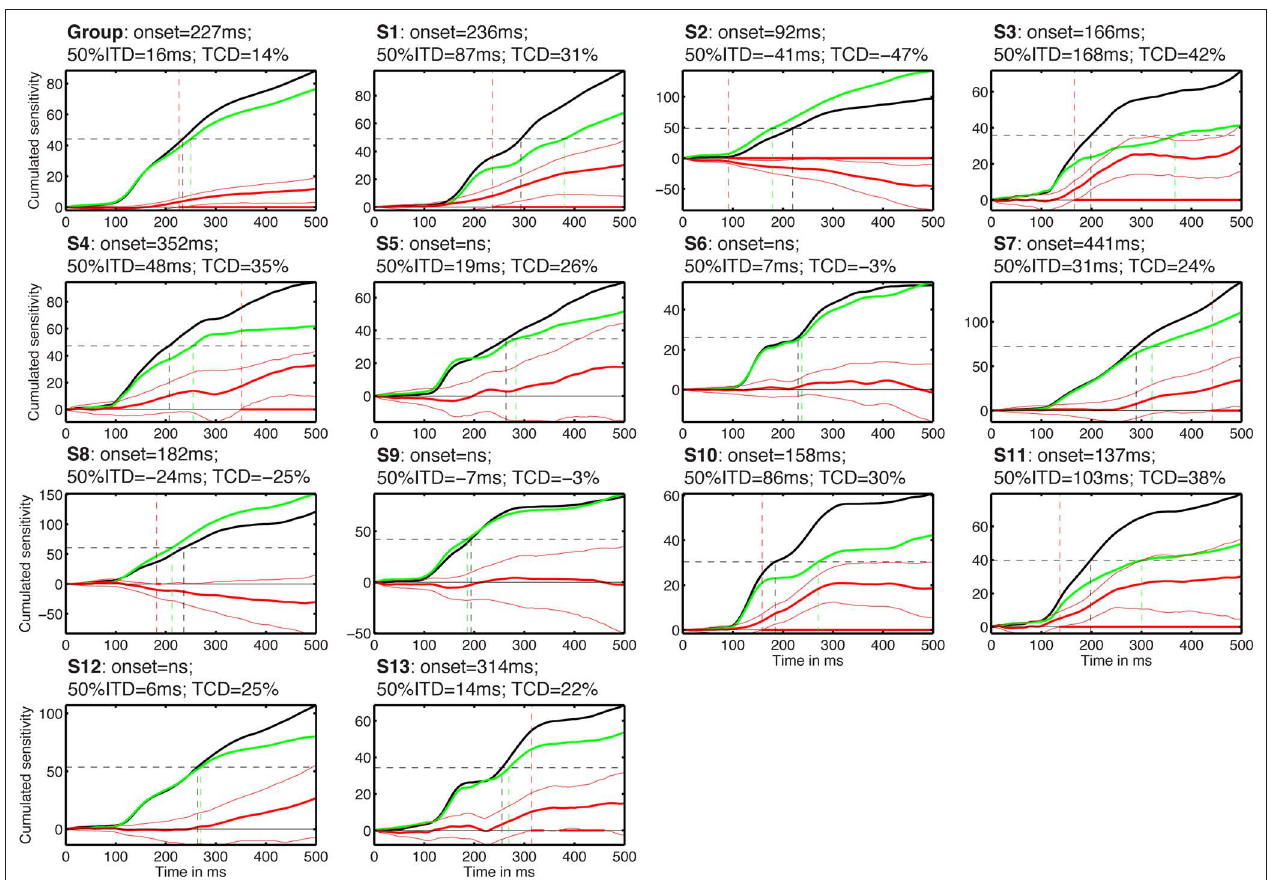
dashed line marks the value corresponding to 50% of the total cumulated sensitivity in the identity task. The two vertical lines that originate from the 50% line and terminate on the x -axis mark the time to reach that 50% value in the two tasks. The title of each cell contains the onset of the task effects; the 50% integration time difference (50% ITD) between the color and the identity tasks; the task cumulated difference (TCD) between the identity and the color tasks, expressed in proportion of the maximum cumulated sensitivity in the